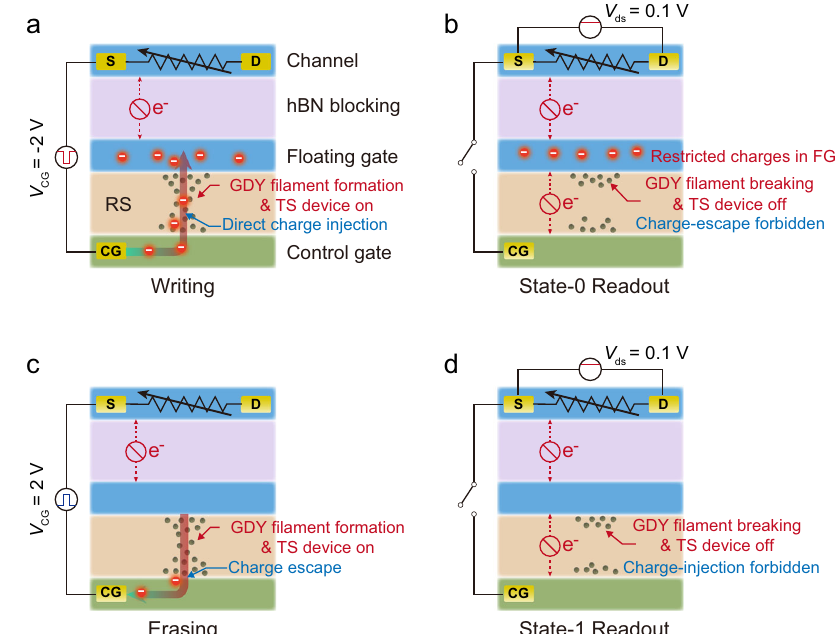
Fig. 4 | Operation mechanisms of the low-voltage ultrafast nonvolatile mem- ory. a Writing operation: driven by a – 2V V CG pulse, GDY fi laments form, and the TSdevice switches on, allowing the direct injection of electrons from control gate to fl oating gate. b State-0 readout: after removing the V CG pulse, GDY fi laments breaks and the TS device switches off, forbidding the escape of injected electrons and thus restricting these electrons in fl oating gate. c Erasing operation: drivenby